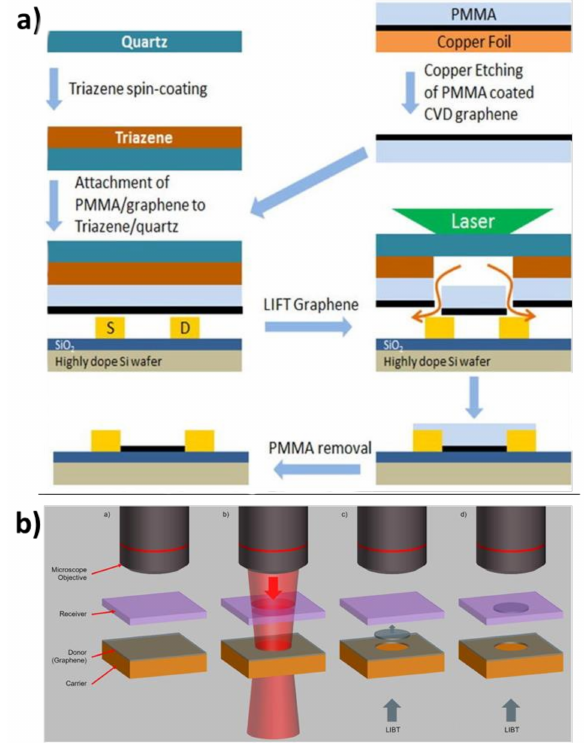
Figure 9. Examples of laser-assisted graphene transfer methods. ( a ) Laser-induced forward transfer experimental workflow. Reprinted with permission from Ref. [95]. Copyright 2017 American Institute of Physics. ( b ) Laser-induced backward transfer schematic, showing liftoff from the original substrate backward onto the target substrate. Reprinted under the terms of the Creative Commons Attribution 4.0 license from Ref. [94]. Copyright 2020